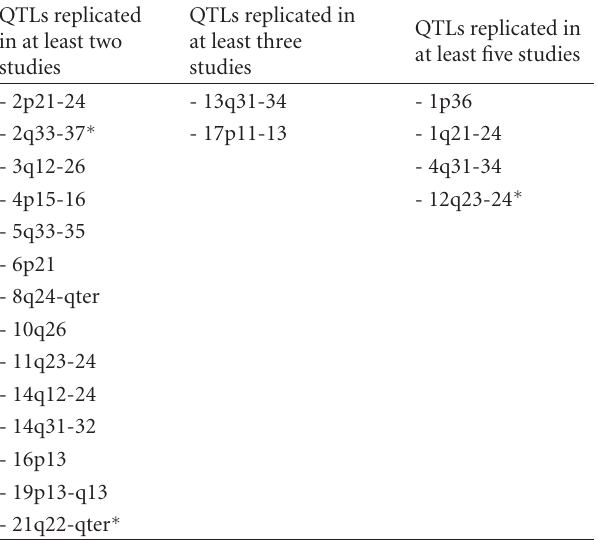
Table 3: QTLs identified and replicated in genome-wide linkage studies for osteoporosis [145]. Asterisks indicate genetic region associated also to clinical CVD events through genome-wide association studies